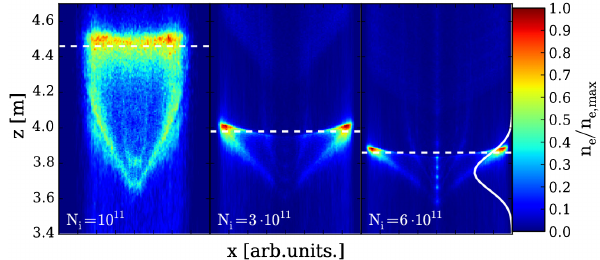
FIG. 7. Electron cloud pinching in horizontal plane y ¼ 0 crossing the pipe center (external magnetic field is on). From ¼ 10 11 , N ¼ 3 × 10 11 and N ¼ 6 × 10 11 . The left to right: N i i i solid gray line shows the position of the bunch and its profile. The FIG. 8. Tune spreads for the LHC-type bunch in round dashed lines depict the pinching points given by Eq. (10). geometry without magnetic field. Uniform cloud density is equal Direction of motion is downwards. to the average realistic cloud density. Bunch population